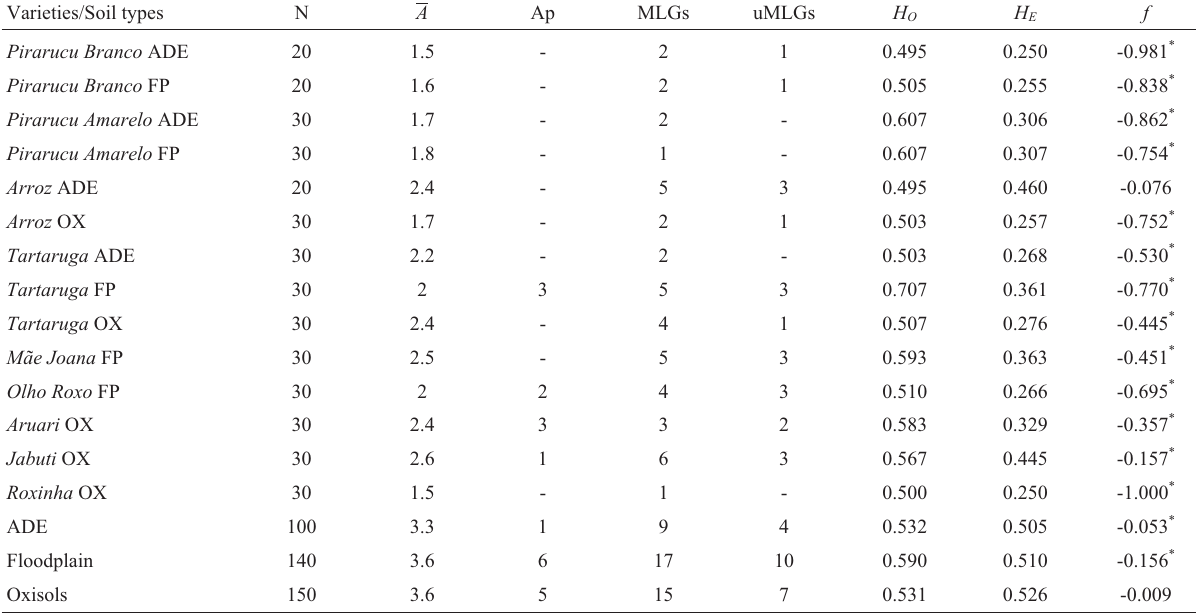
Table 2 - Genetic diversity parameters estimated for 14 bitter manioc varieties grown in three different soil types in Manicoré, Amazonas, Brazil, and for the set of varieties in each soil type, based on 10 microsatellite loci. Number of individuals (N), mean number of alleles ( A ), number of private alleles (Ap),numberofmultilocusgenotypes(MLGs),numberofuniquemultilocusgenotypes(uMLGs),observed( H O )andexpected( H E )heterozygositiesand inbreedingcoefficients( f ).SoiltypesarecodedasADE(Amazoniadarkearths),FP(floodplain)andOX(Oxisols).Significantvaluesof f *(p<0.05)are